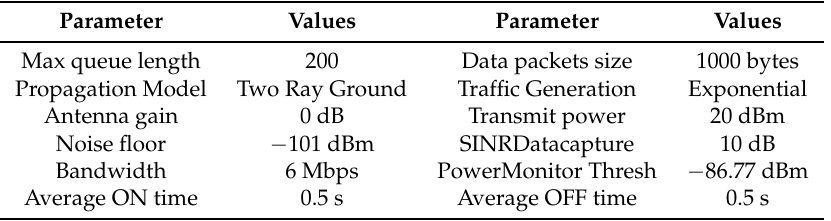
Table 3. Simulation